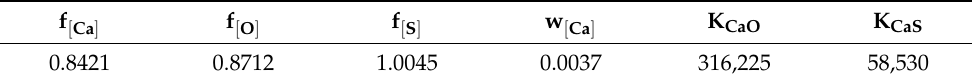
Table 5. Thermodynamic calculation values. f [ Ca